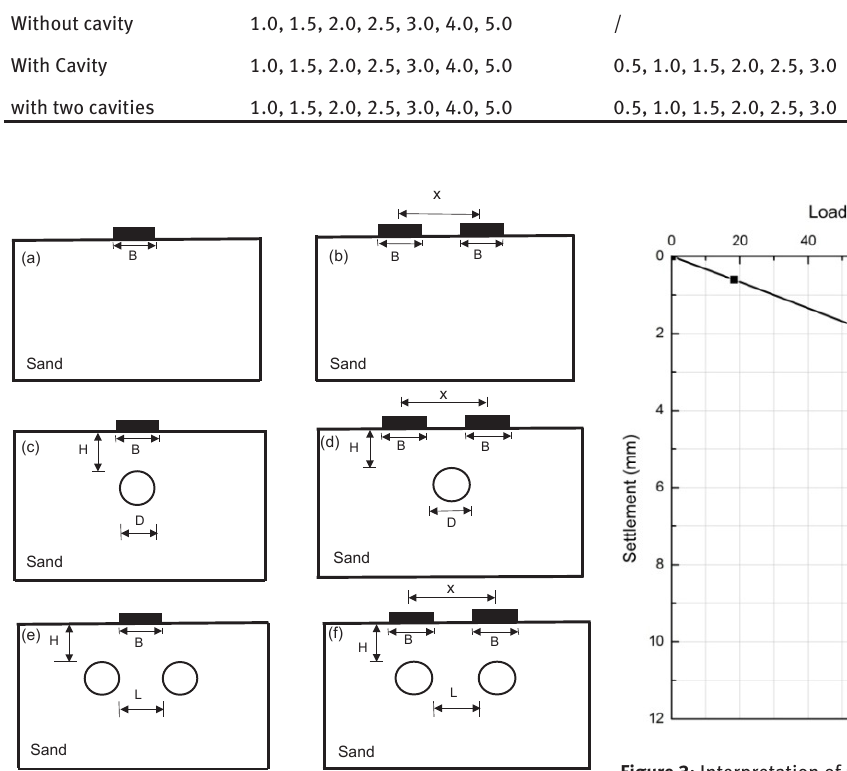
Figure 2: Models used in this study: (a) isolated footing; (b) two adjacent strip footings; (c) isolated footing with cavity; (d) two adjacent strip footings with cavity; (e) isolated footing with two cavities; (f) two adjacent strip footings with two cavities